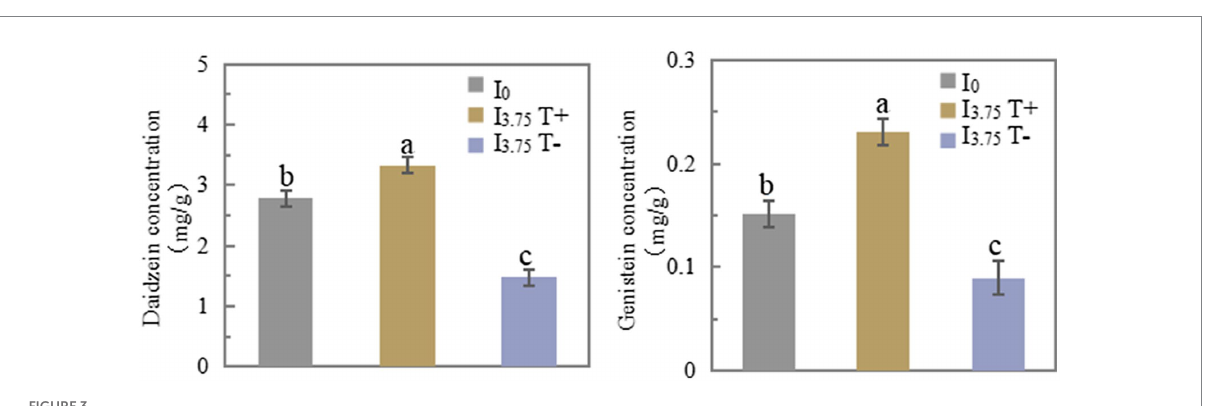
FIGURE 3 Changes in daidzein and genistein concentrations in roots after unilateral supply of isoflavones, different lowercase letters above the bars indicate significant difference ( p < 0.05) by Duncan’s multiple range test. I 0 refers to conventional nutrient solution applied on both sides; I 3.75 T+ is the treatment side of unilateral application of nutrient solution containing daidzein and genistein, and I 3.75 T-is the untreated side of the unilateral application of nutrient solution that contained daidzein and genistein.